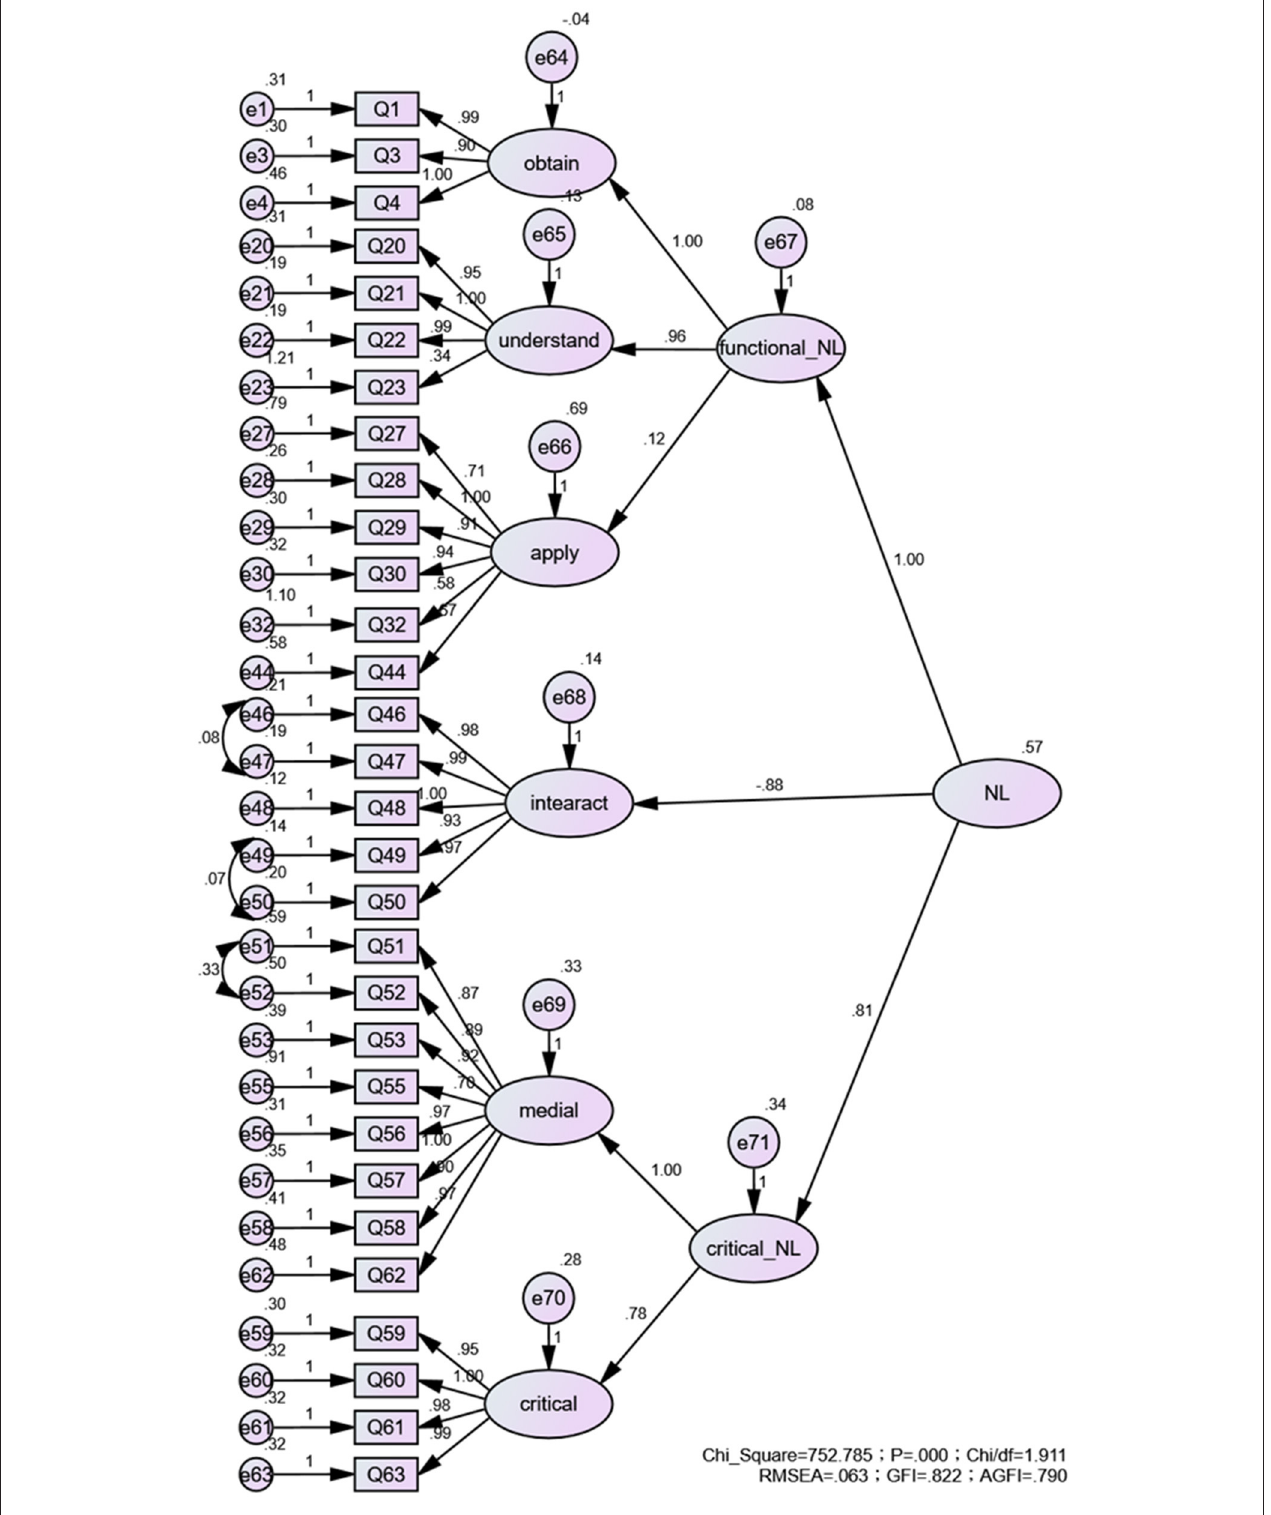
FIGURE 3 | Second-order CFA analysis factor loading construct validity study for CM-NL.